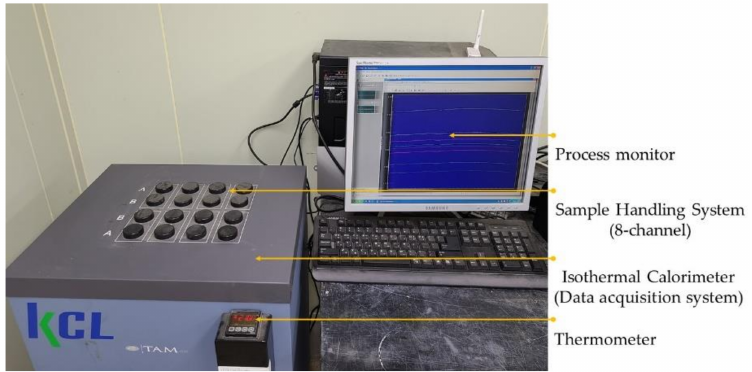
Figure 4. TAM Air isothermal